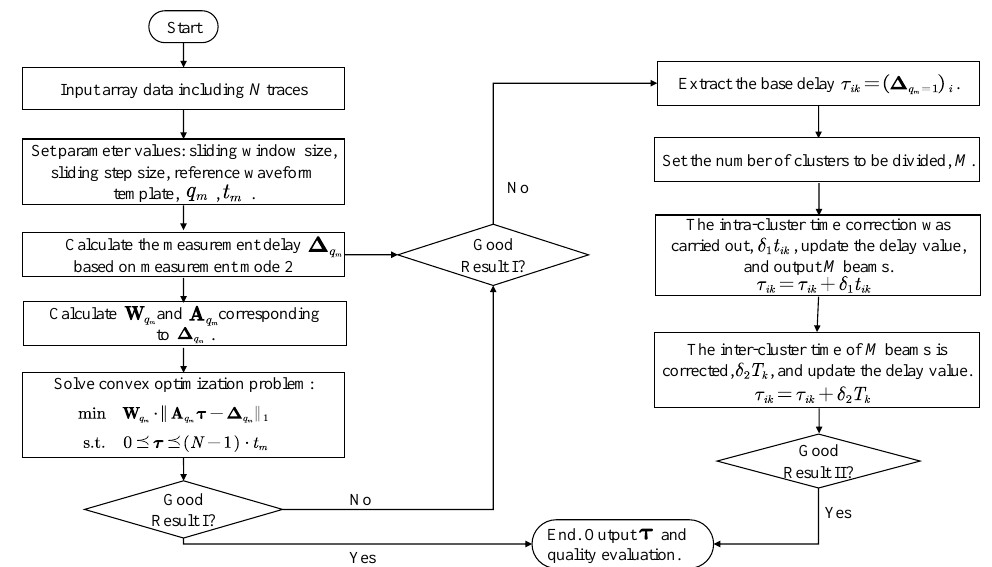
Figure 4. Flowchart of the hybrid method proposed in this paper.